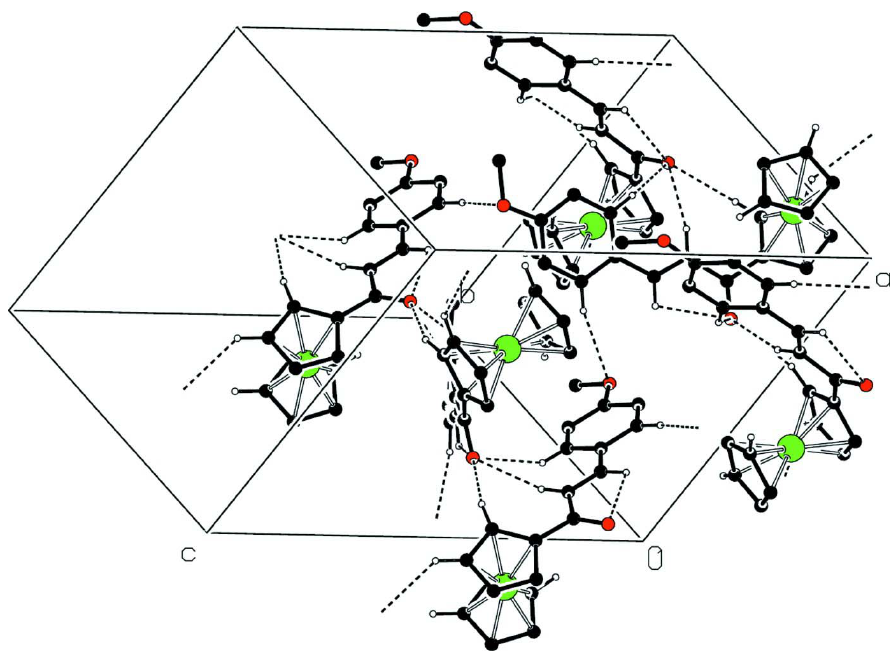
Figure 2 Unit cell packing of (I) showing the hydrogen bonded chains (dashed lines). For clarity, H atoms not involved in hydrogen bonding have been